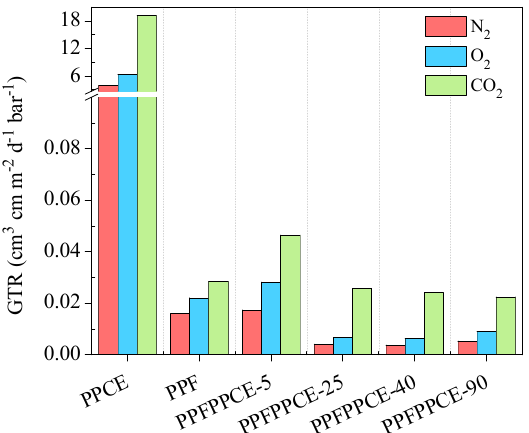
Figure 4. Gas Transmission Rate (GTR) of O 2 , N 2 , and CO 2 through PPCE, PPF, and PPFPPCE-t copolymers.